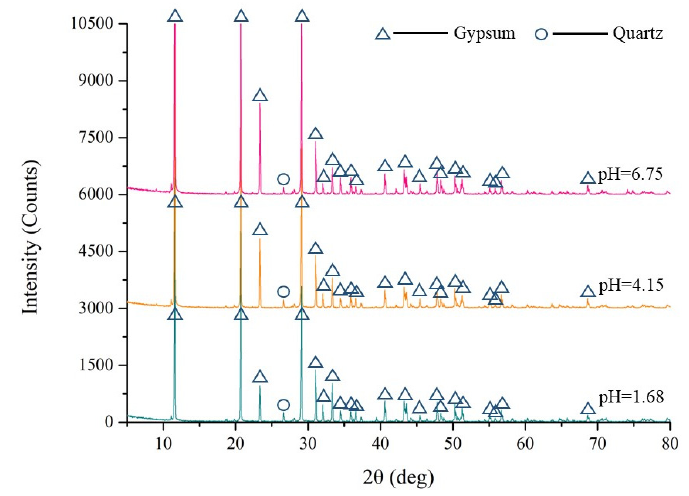
Figure 3. X-ray diffraction analysis of Figure 3. X ‐ ray diffraction analysis of PG.